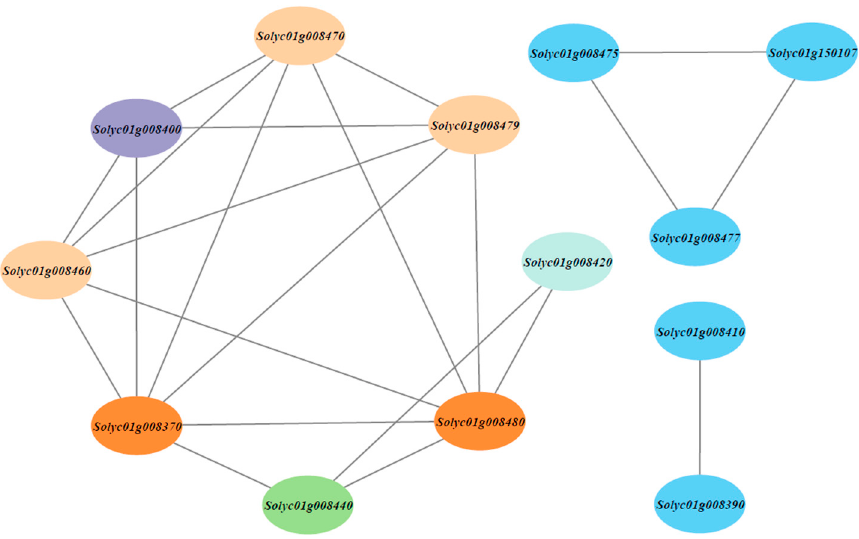
Figure 6. The network analysis of gene coexpression within the identified genes in tomatoes.